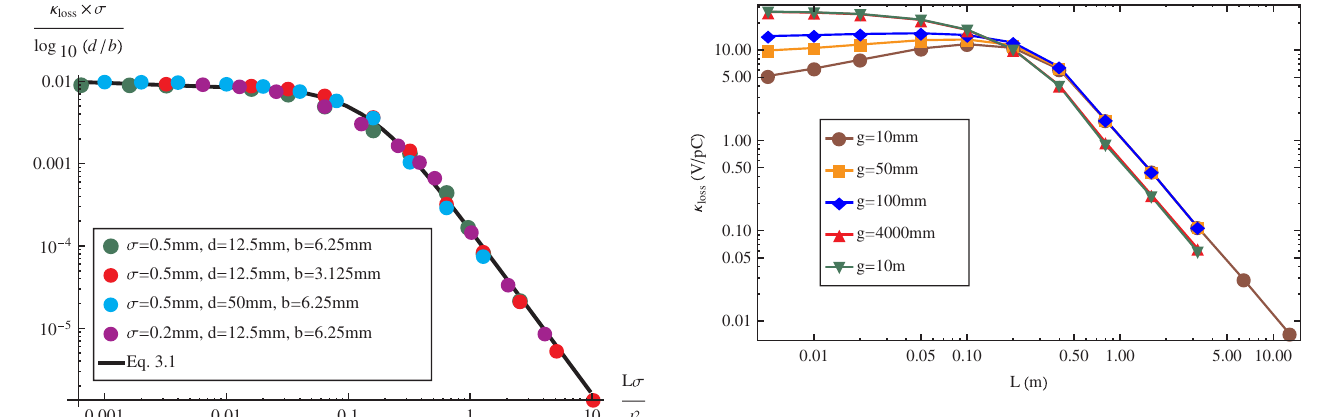
FIG. 13. (Color) For different values of g , we show the loss factor as calculated with ECHO as a function of taper length L for FIG. 11. (Color) For a variety of tapered collimators with g ¼ the cavity with parameters: b ¼ 6 : 25 mm , d ¼ 25 mm and (cid:1)= log ð d=b Þ , 500 mm , we plot the scaled loss factor, (cid:2) loss Gaussian bunch with rms length (cid:1) ¼ 0 : 5 mm . The curves are [ V - m = pC ] versus the dimensionless scaled length L(cid:1)=d 2 . just guides for the eye. Results of ECHO calculations for the loss factor are shown for parameters: (cid:1) ¼ 0 : 5 mm , d ¼ 12 : 5 mm , b ¼ 6 : 25 mm (green dots); (cid:1) ¼ 0 : 5 mm , d ¼ 12 : 5 mm , b ¼ 3 : 125 mm (red dots); (cid:1) ¼ 0 : 5 mm , d ¼ 50 mm , b ¼ 6 : 25 mm (aqua dots); and (cid:1) ¼ 0 : 2 mm , d ¼ 12 : 5 mm , b ¼ 6 : 25 mm (purple dots). The black curve is given by Eq. (3.1).